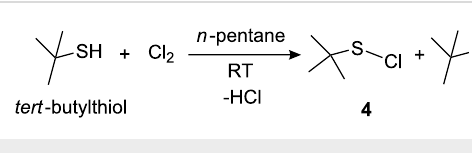
Scheme 3: Synthesis of tert -butylsulfanyl chloride.